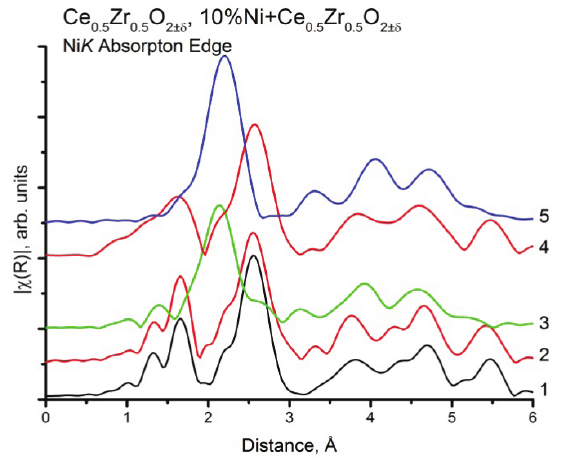
Figure 8: Fourier Transform of X-ray absorption spectra near Ni K absorption edge: 1 – Ni+ Ce 800°C; 3 – Ni+Ce